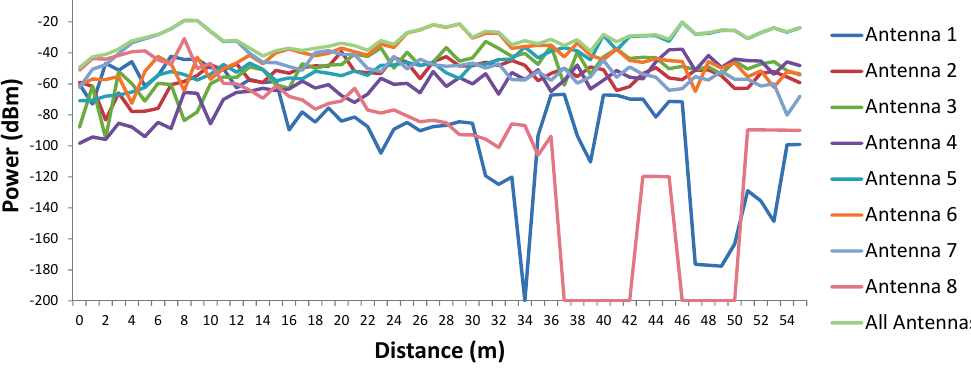
Figure 6. Estimated received power vs. linear distance for the antennas transmitting separately and